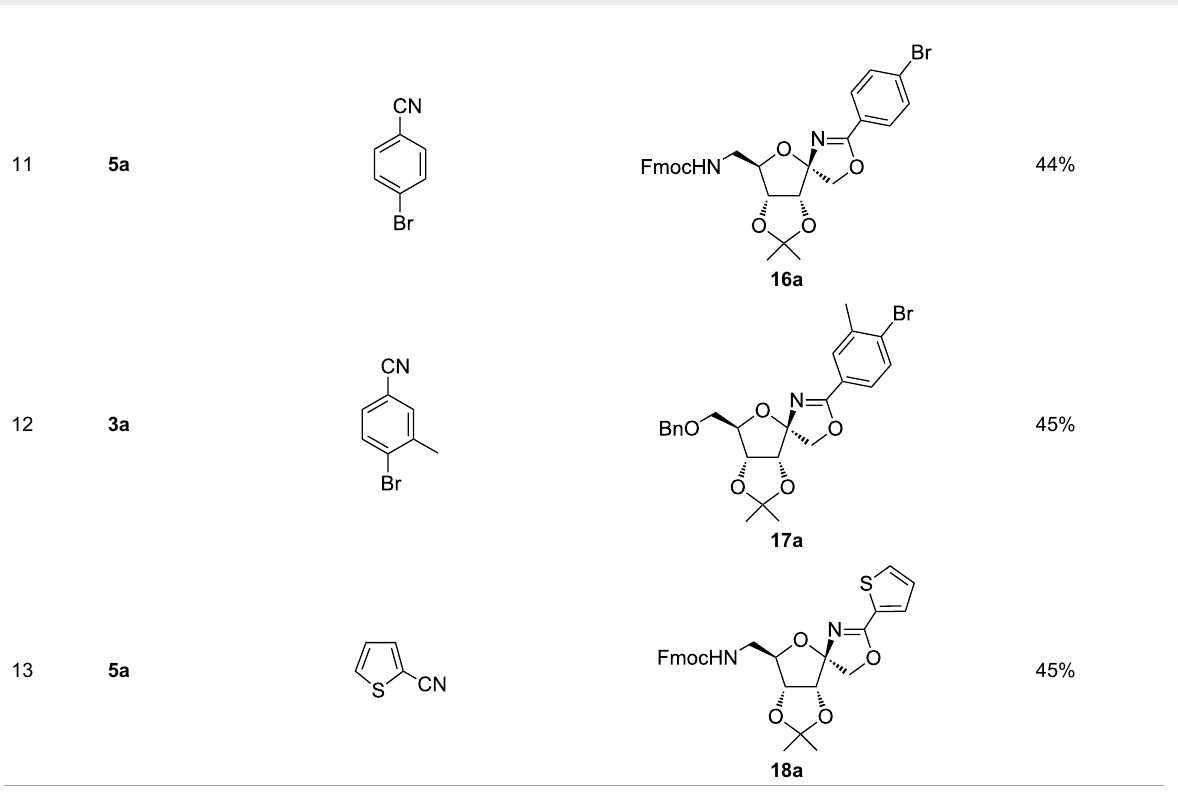
Table 1: Synthesis of spiro 2-substituted-2-oxazolines 6a–18a .